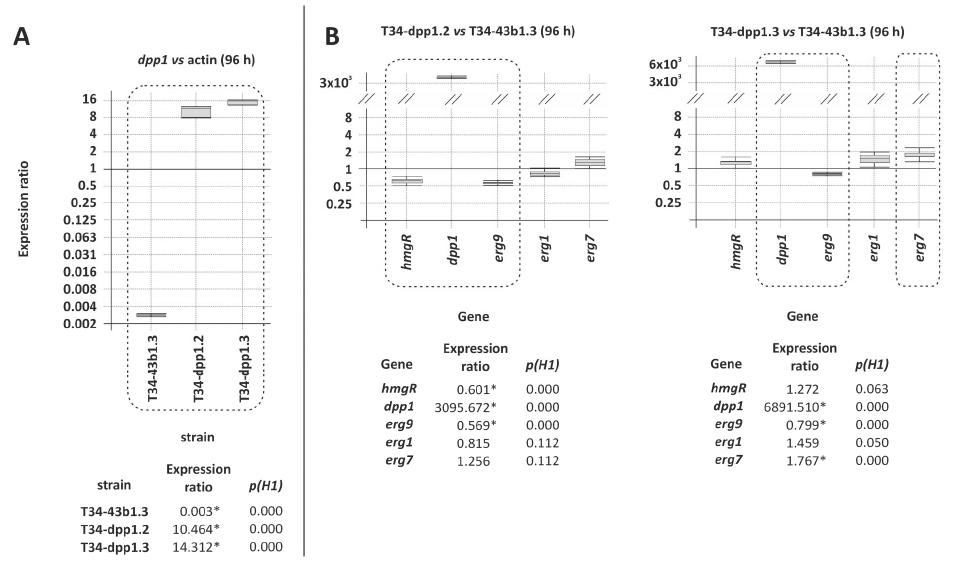
Figure 3. qPCR analysis from 96 h PDB grown mycelia to assess the transcription level of: ( A ) dpp1 gene in the control strain, T34 ‐ 43b1.3, that was generated from T. harzianum CECT 2413 by transformation with the empty expression vector used for dpp1 overexpression, and in two dpp1 ‐ overexpressing transformants T34 ‐ dpp1.2 and T34 ‐ dpp1.3, relative to the expression of actin gene, used as an internal control (housekeeping). ( B ) Five genes involved in the terpene biosynthetic pathway in the two selected transformants compared versus expression in T34 ‐ 43b.1. In the graphic representation, those statistically significant differential expression data ( p < 0.05) are squared with dashed lines and numeric values were labeled with an asterisk (*) at the bottom of each graphic.